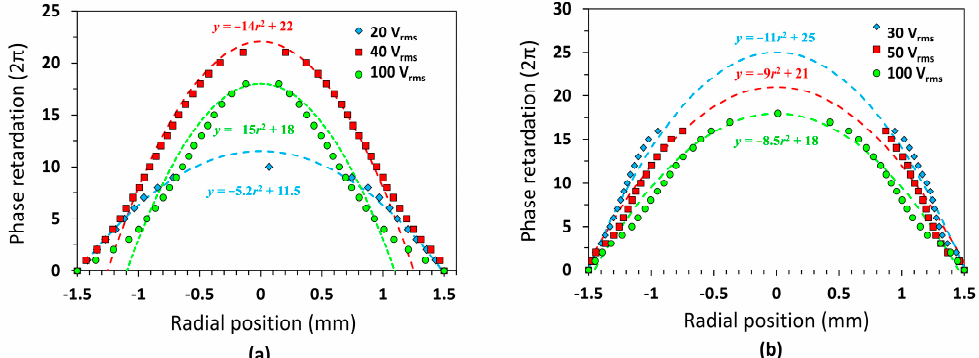
Figure 7. The radial phase retardation profiles of the TLCL lens with respect to various applied voltages: ( a ) Radial phase retardation in the LCL-2 layer is the same as the interference patterns in Figure 4g–i; ( b ) Radial phase retardation in the LCL-1 layer is same as the interference patterns in Figure 5d–f.